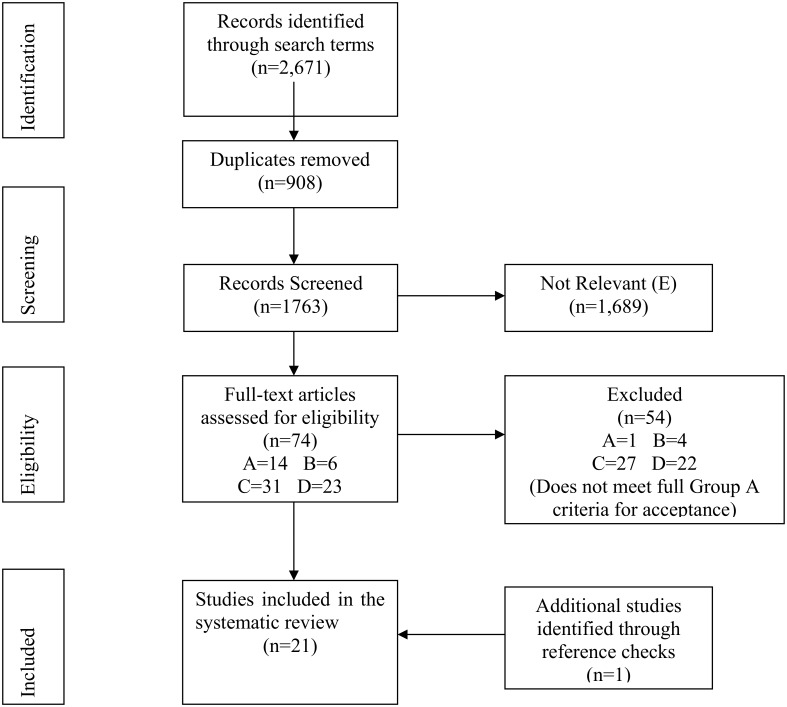
Identification of studies for final review.